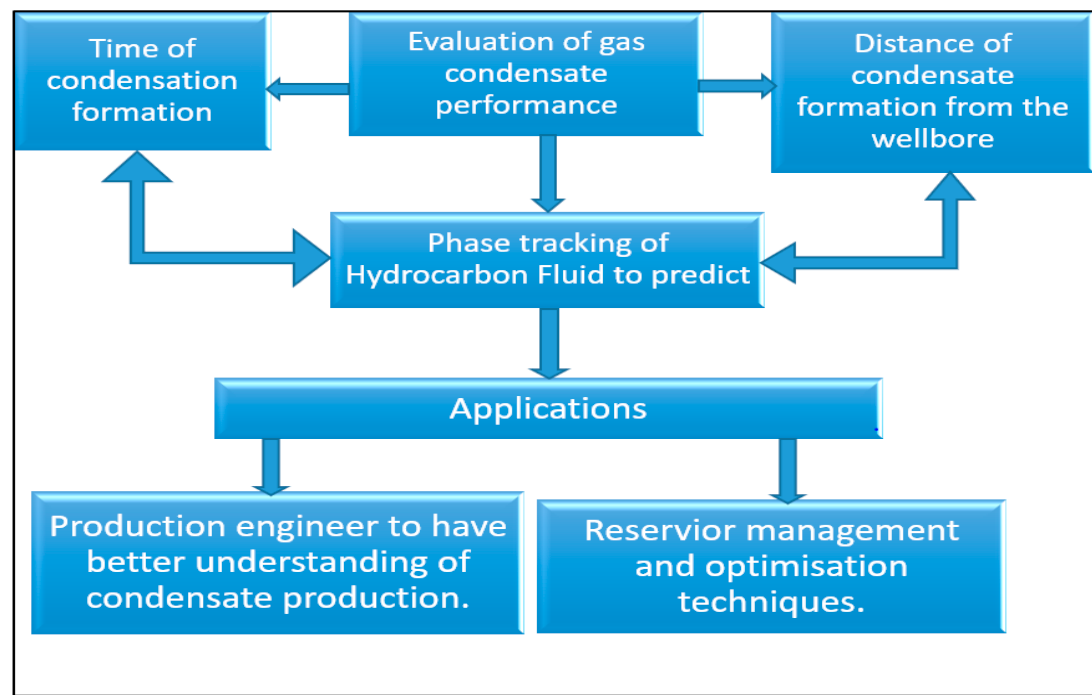
Figure 1. Schematic illustration of the formulation of the general problem and application of the proposed approach to tackle it.